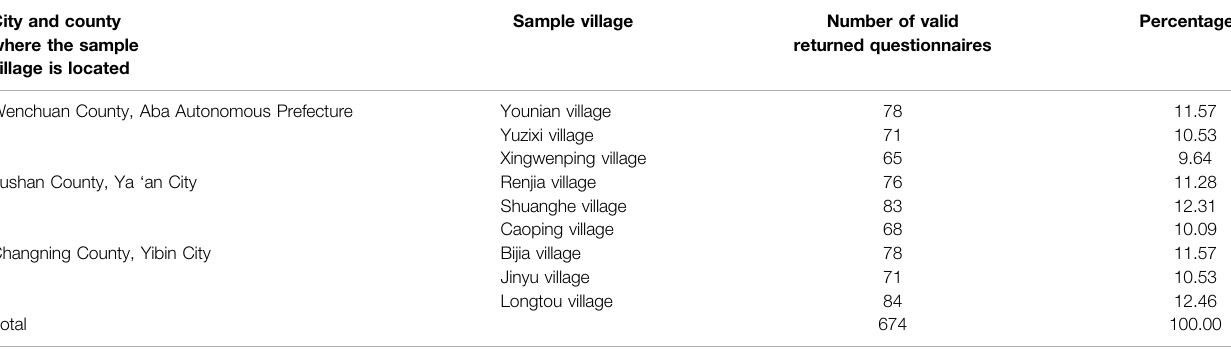
TABLE 2 | Number and proportion of questionnaires collected by villages. City and county where the sample village is